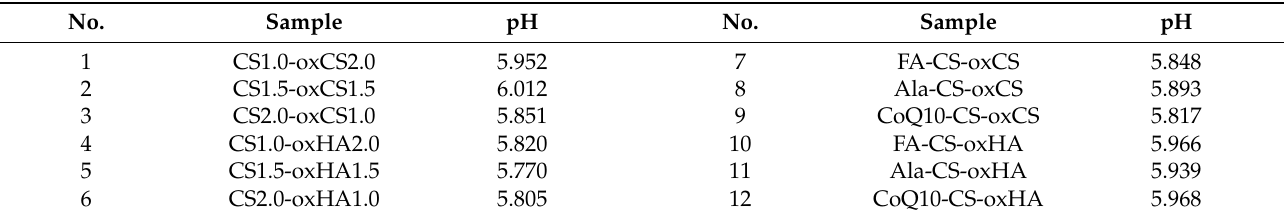
Table 5. The pH values recorded for CS-oxCS/oxHA and API-CS-oxCS/oxHA